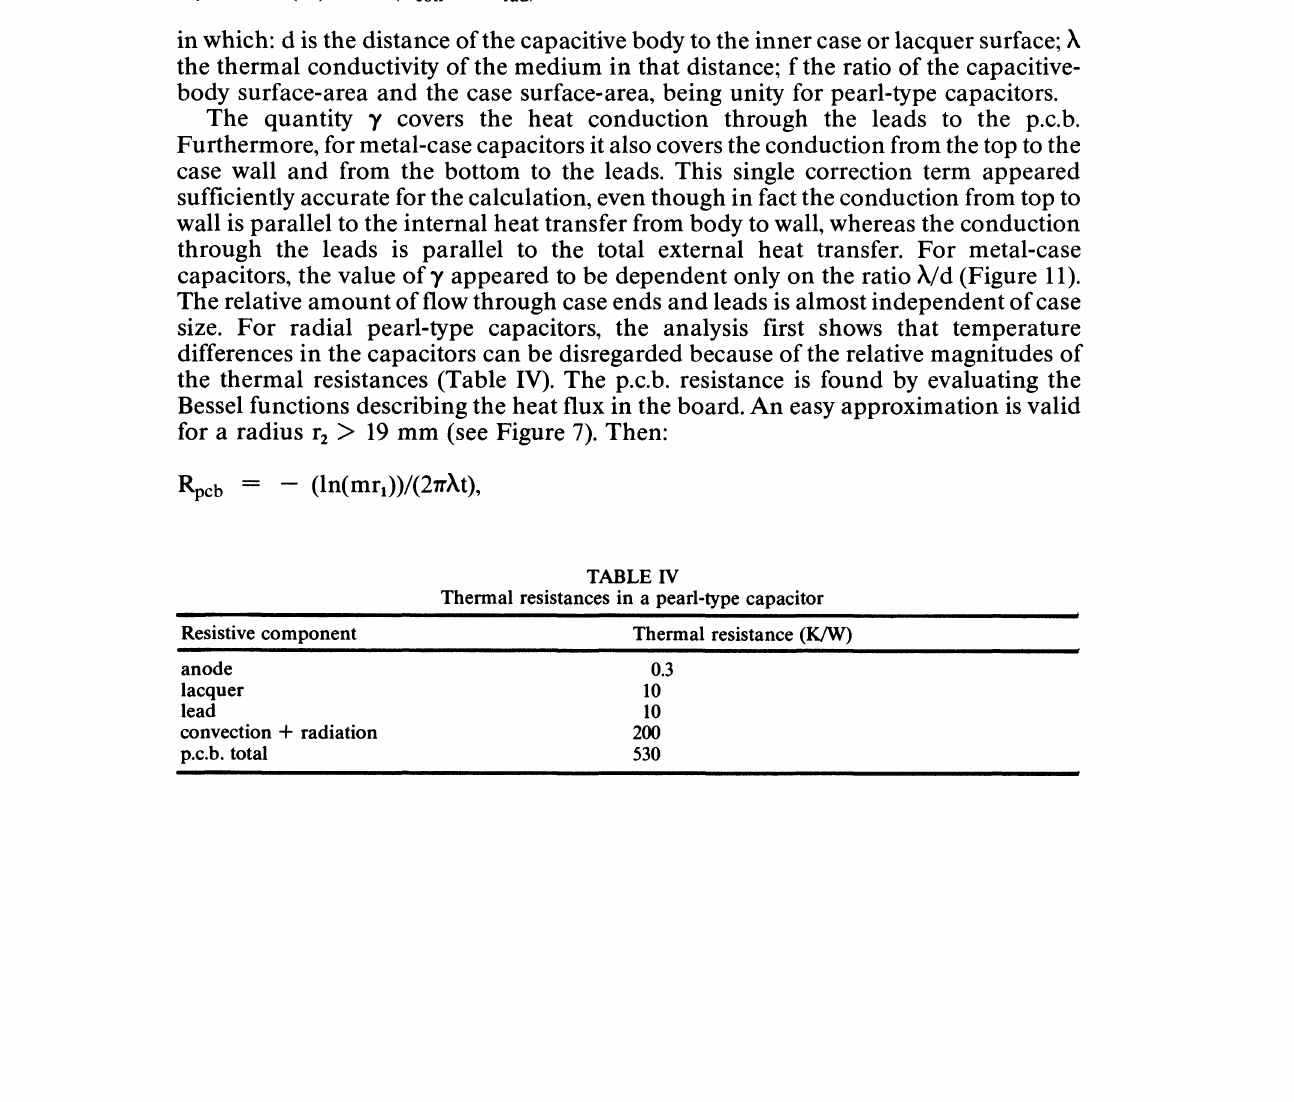
FIGURE 11 Correction factor 7 as a function of the ratio Md, for metal-case capacitors.